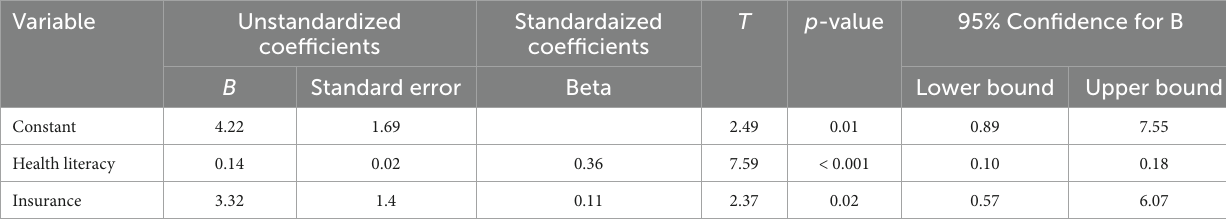
TABLE 4 Multiple regression analysis summary for the use of complementary and alternative